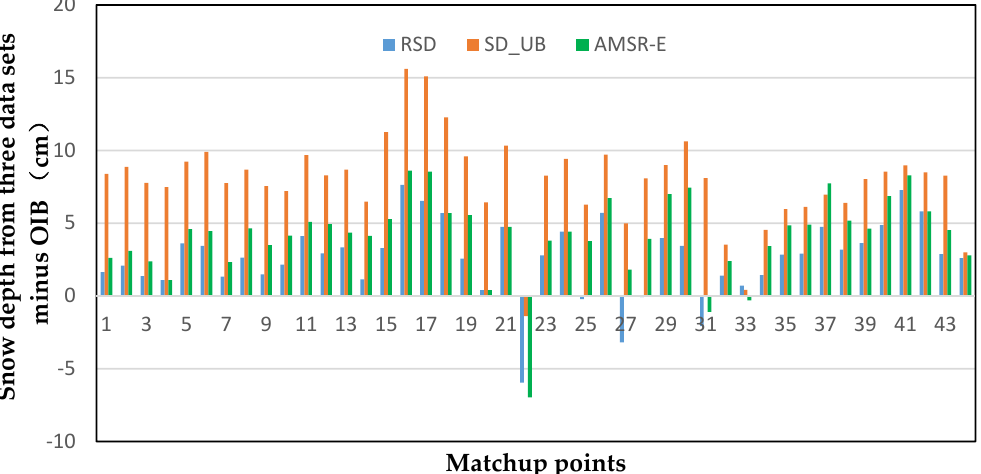
Figure 19. Differences in snow depth on FYI between three datasets and OIB on 42 matchup points.